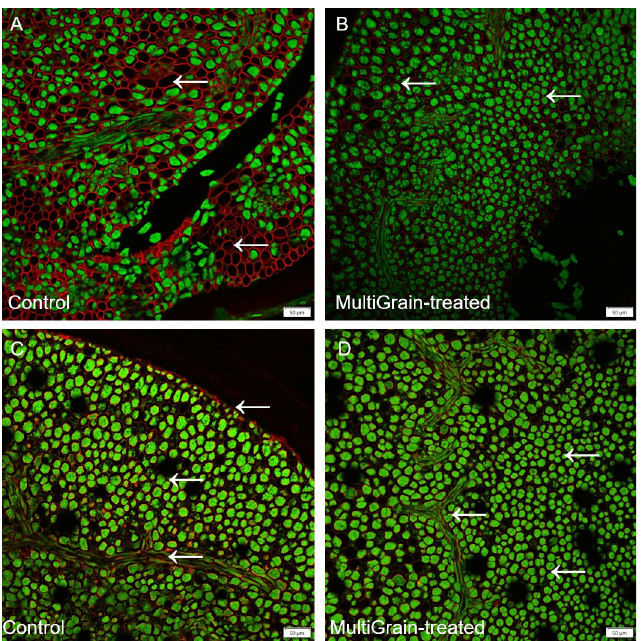
Fig 7. Confocal images of cross sections of whole rapeseed seeds. Sections of sample incubated (A, C) with sodium acetate buffer (control) or (B, D) with MultiGrain for 3 hours at pH 5. Slides were subsequently incubated with (A, B) the LM25 antibody detecting xyloglucans or (C, D) with the LM6 antibody detecting (1–5)- α -L-arabinans. Red fluorescence labelled secondary antibody used for visualization of sections. Red signal indicates (A, B) xyloglucans or (C, D) arabinans and the green signal indicates autofluorescence from proteins bodies. Arrows point to sites where the fluorescence signal due to staining or immunolabelling is present and removed following treatment with MultiGrain. Scale bar = 50 μ